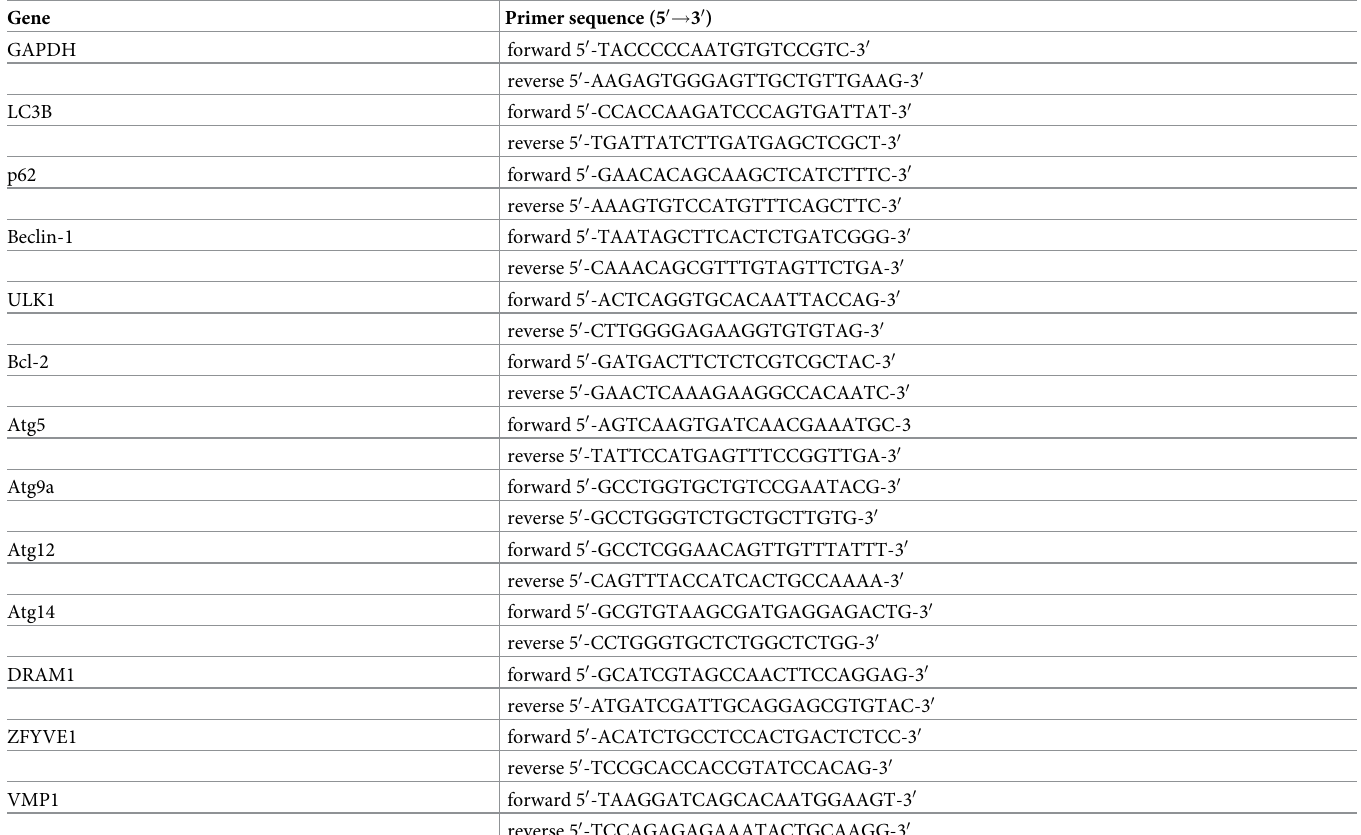
Table 1. The primer sequences used for